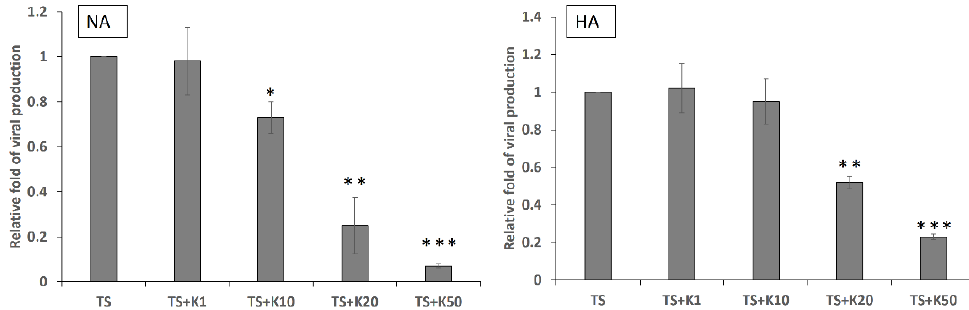
Figure 5. Kaempferol treatment inhibits EBV viral production in NPC cell lines. NA and HA cell